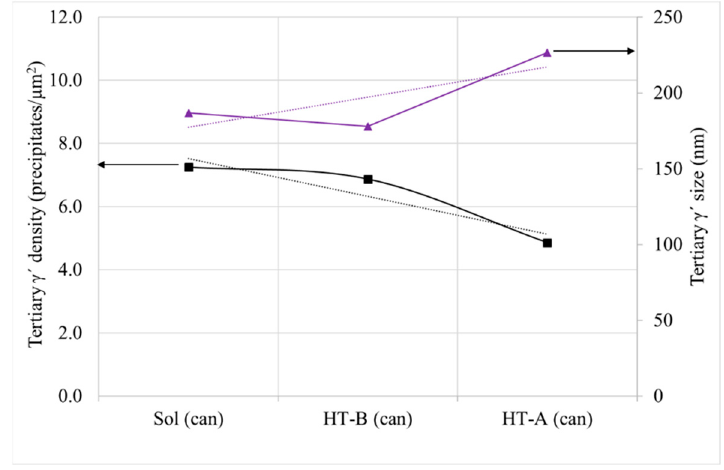
Figure 21. Relationship between tertiary γ′ density, size and following HTs (Sol: Solution, HT-B: Sol + P2 and HT-A: Sol + S1 + S2 + P1 + P2).